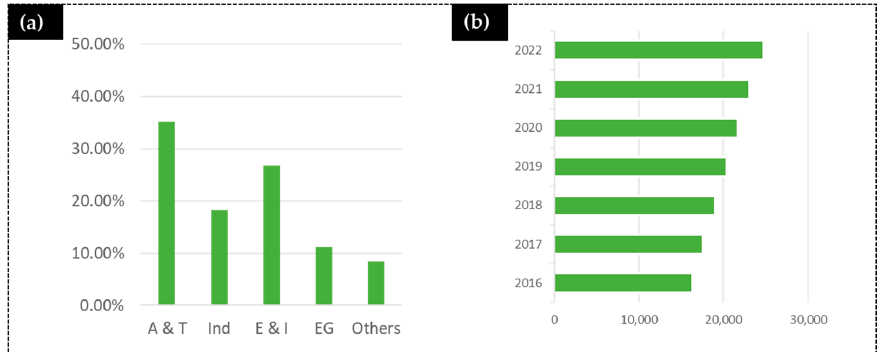
Figure 3. Soft magnetic materials ( a ) world market share (2016). A&T—automotive and transportation; Ind—industrial; E & I—electronics and instrumentation; EG—energy generation. ( b ) Market transactions and predictions (in USD billion) (based on images from